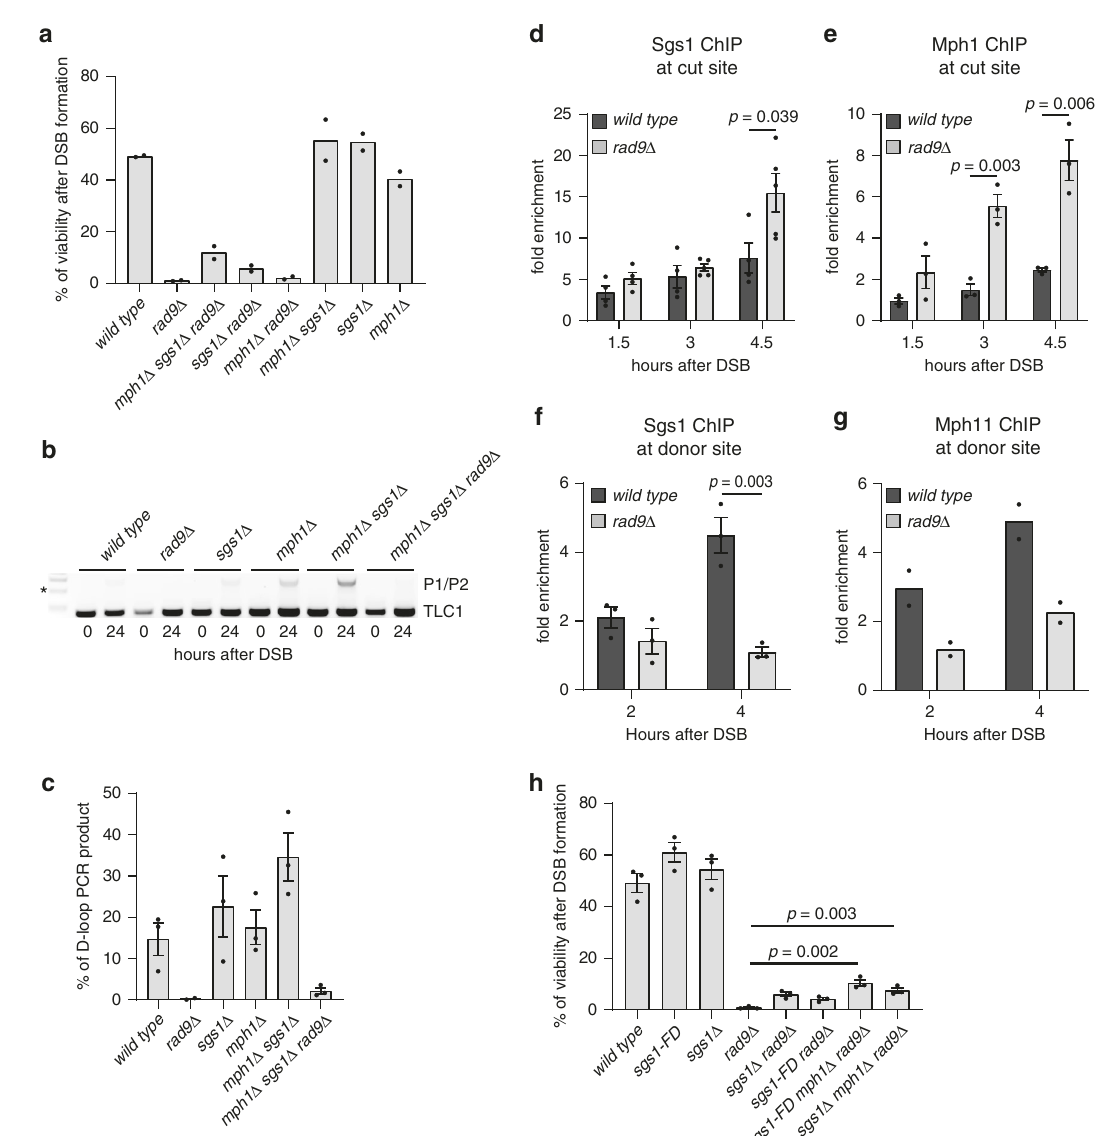
Fig. 5 Rad9 promotes D-loop extension in BIR by limiting Sgs1 and Mph1. a BIR ef fi ciency measured by cell viability in the indicated JRL092 strains ( n = 2 biologically independent experiments). b PCR-based assay to test D-loop extension in the indicated JRL092 strains, (*) indicates the 1000 bp band of the 1 kb DNA ladder (NEB). c Quanti fi cation of the D-loop extension as in ( b ) ( n = 3 biologically independent experiments). Sgs1 ( d ) binding at the DSB site